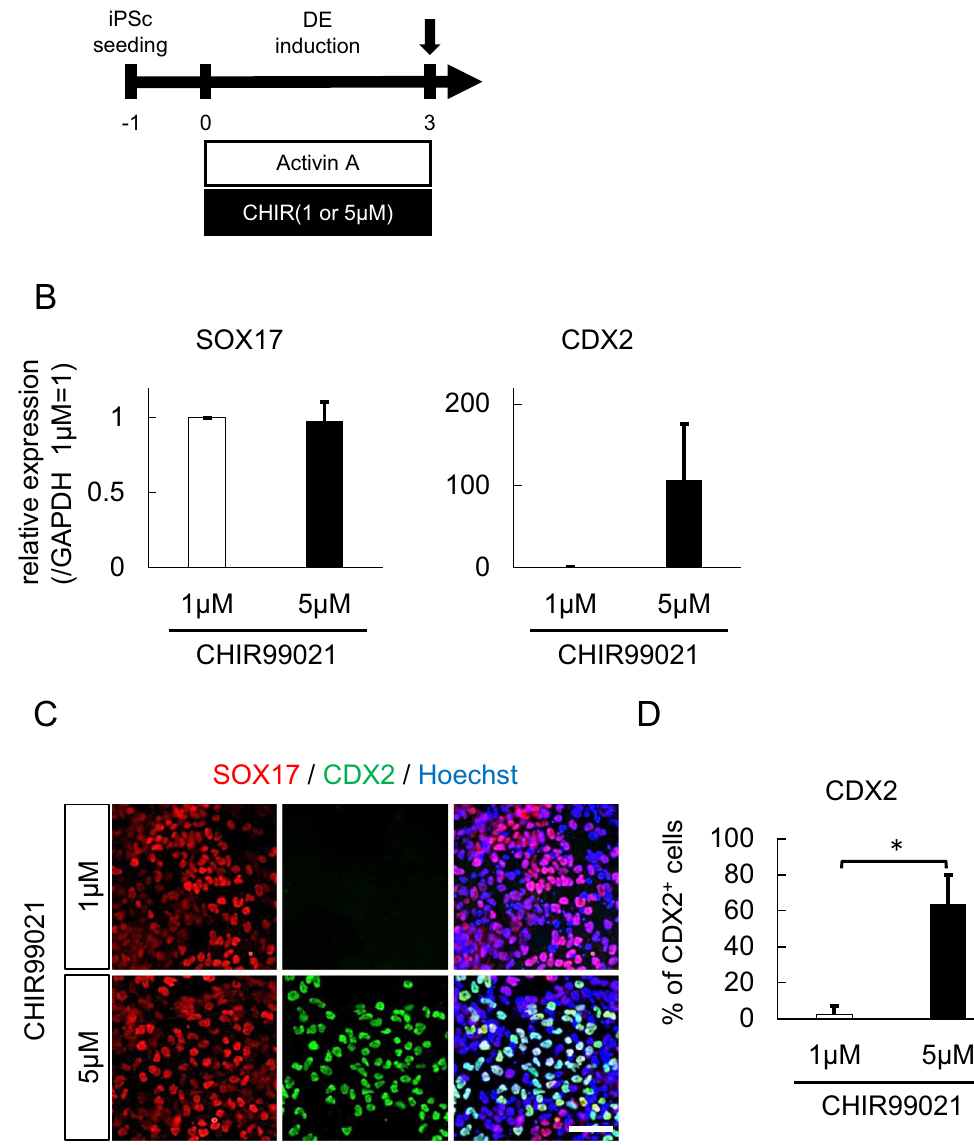
Figure 1. Treatment with a high-dose GSK3 β inhibitor predominantly induced posterior DE. ( A ) A schematic diagram of posterior DE induction using Activin A and CHIR99021. ( B ) An expression analysis of SOX17 and CDX2 in differentiated cells treated with the indicated dose of CHIR by qPCR (n = 3 independent experiments; mean ± SEM). ( C ) Immunostaining of SOX17 and CDX2 in differentiated cells. Representative fluorescence microscopic images for treatment with 1 µ M (upper panels) and 5 µ M CHIR (lower panels) are shown. Scale bar, 50 μ m. ( D ) The proportion of CDX2-positive cells after treatment with 1 or 5 µ M CHIR (n = 3 independent experiments; mean ± SD). * p < 0.05; two-tailed paired t -test. Abbreviations: iPSc, induced pluripotent stem